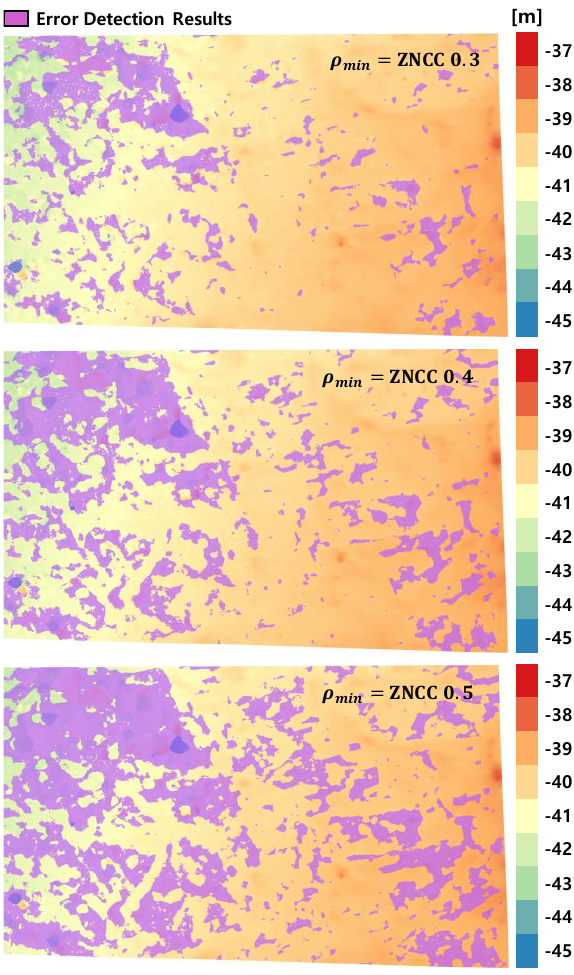
Figure 7. Incorrect match detection results for the target